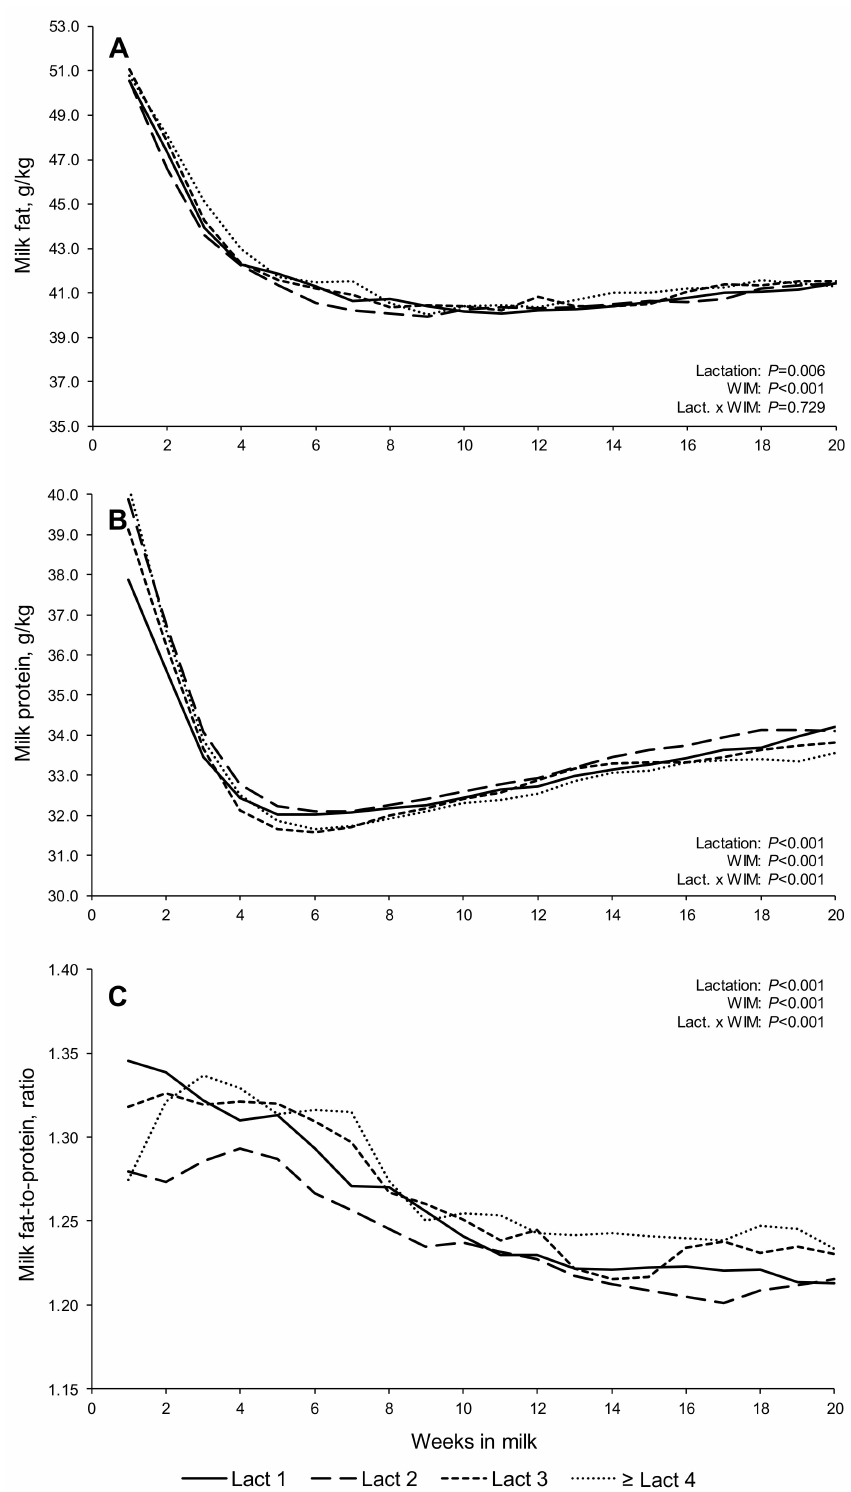
Figure 2. Least squares means, adjusted by the random crossed effects of study and cow, for milk composition variables—milk fat ( A ); milk protein ( B ); and milk fat-to protein ratio ( C )—in early lactation dairy cows (1–20